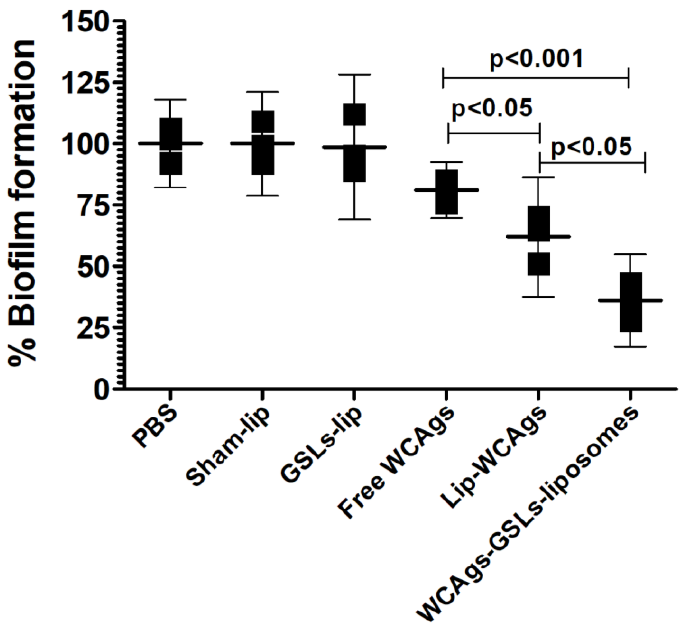
Figure 6. The anti‑sera from the mice immunized with WCAgs‑GSLs‑liposomes were the most ef‑ fective in inhibiting the biofilm formation by A. baumannii . The data are shown as the mean ± SD of three values.